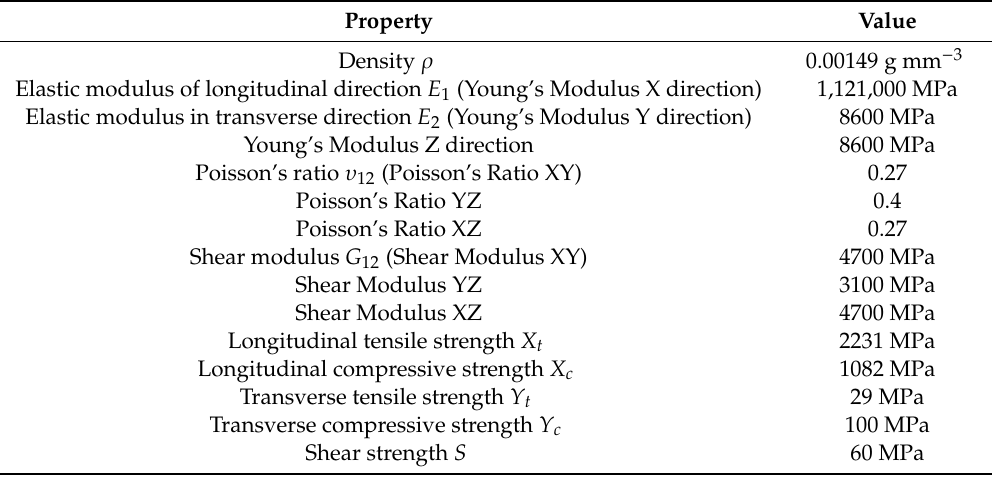
Table A3. Epoxy carbon unidirectional (230 GPa) prepreg orthotropic